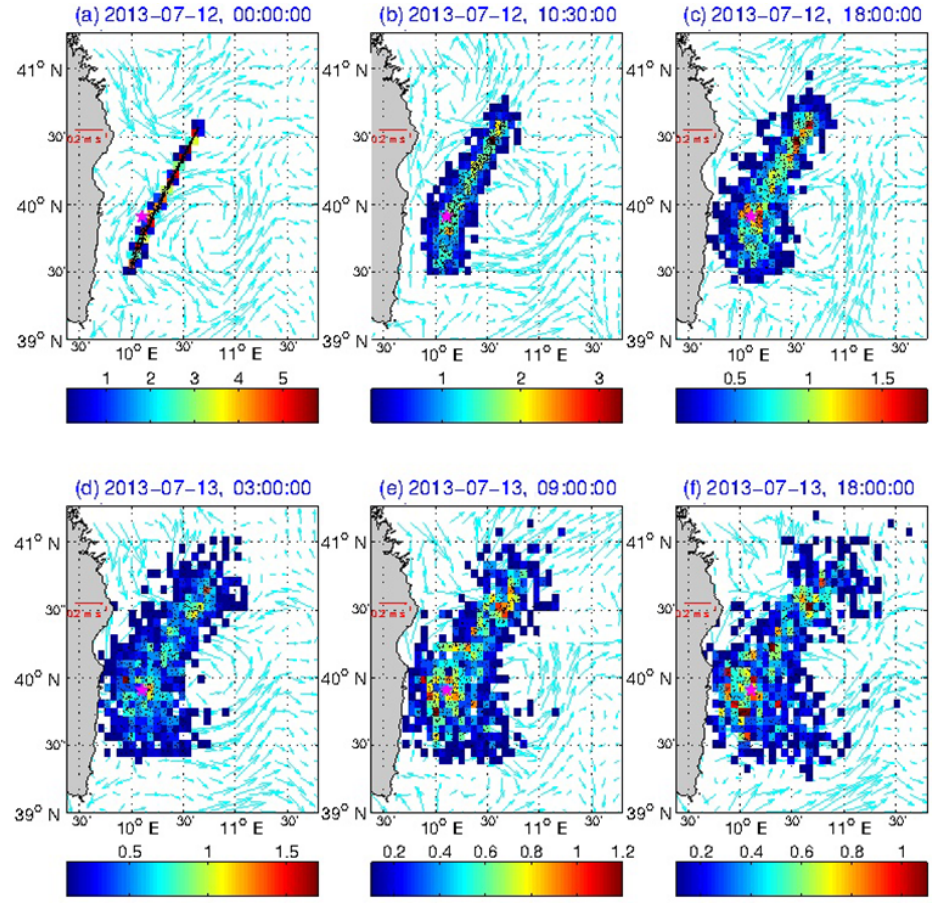
Figure 6. Here the standard error coefficients are 4 times greater than ones in Breivik and Allen (2008) (red line in Fig. 5). Now the particles’ cloud includes the target at the rescue time, but the dispersion is much larger than that shown in Fig. 3.